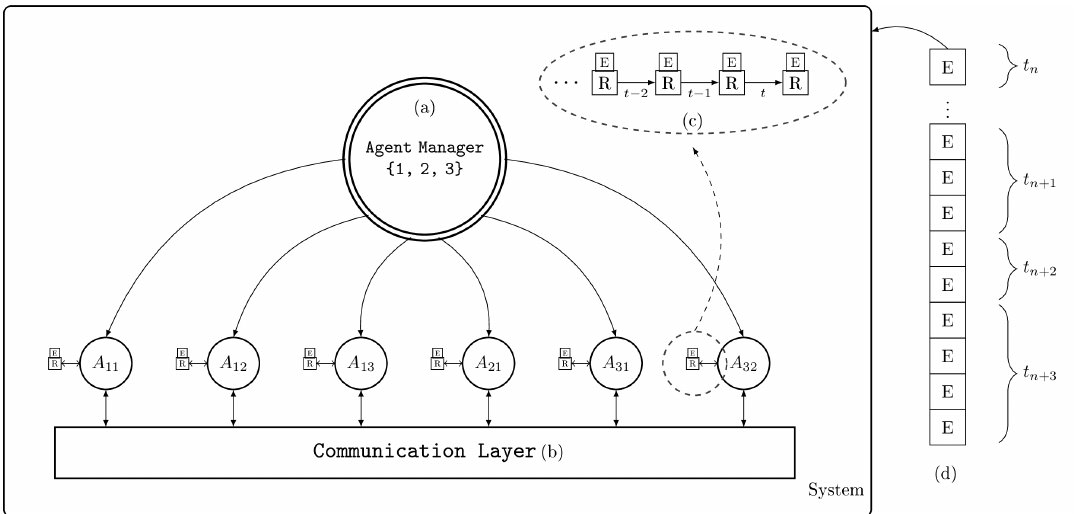
Figure 4. Agent Manager in Simulator